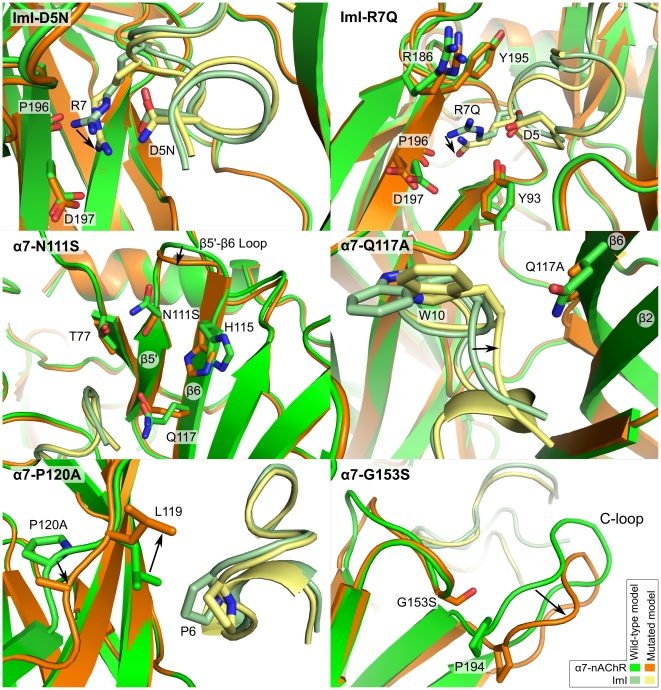
Superimposition of wild-type and mutated models.The models of the mutants shown were refined using molecular dynamics and the conformations shown in this figure are the last frames of the molecular dynamics trajectories. The arrows highlight local conformational changes.